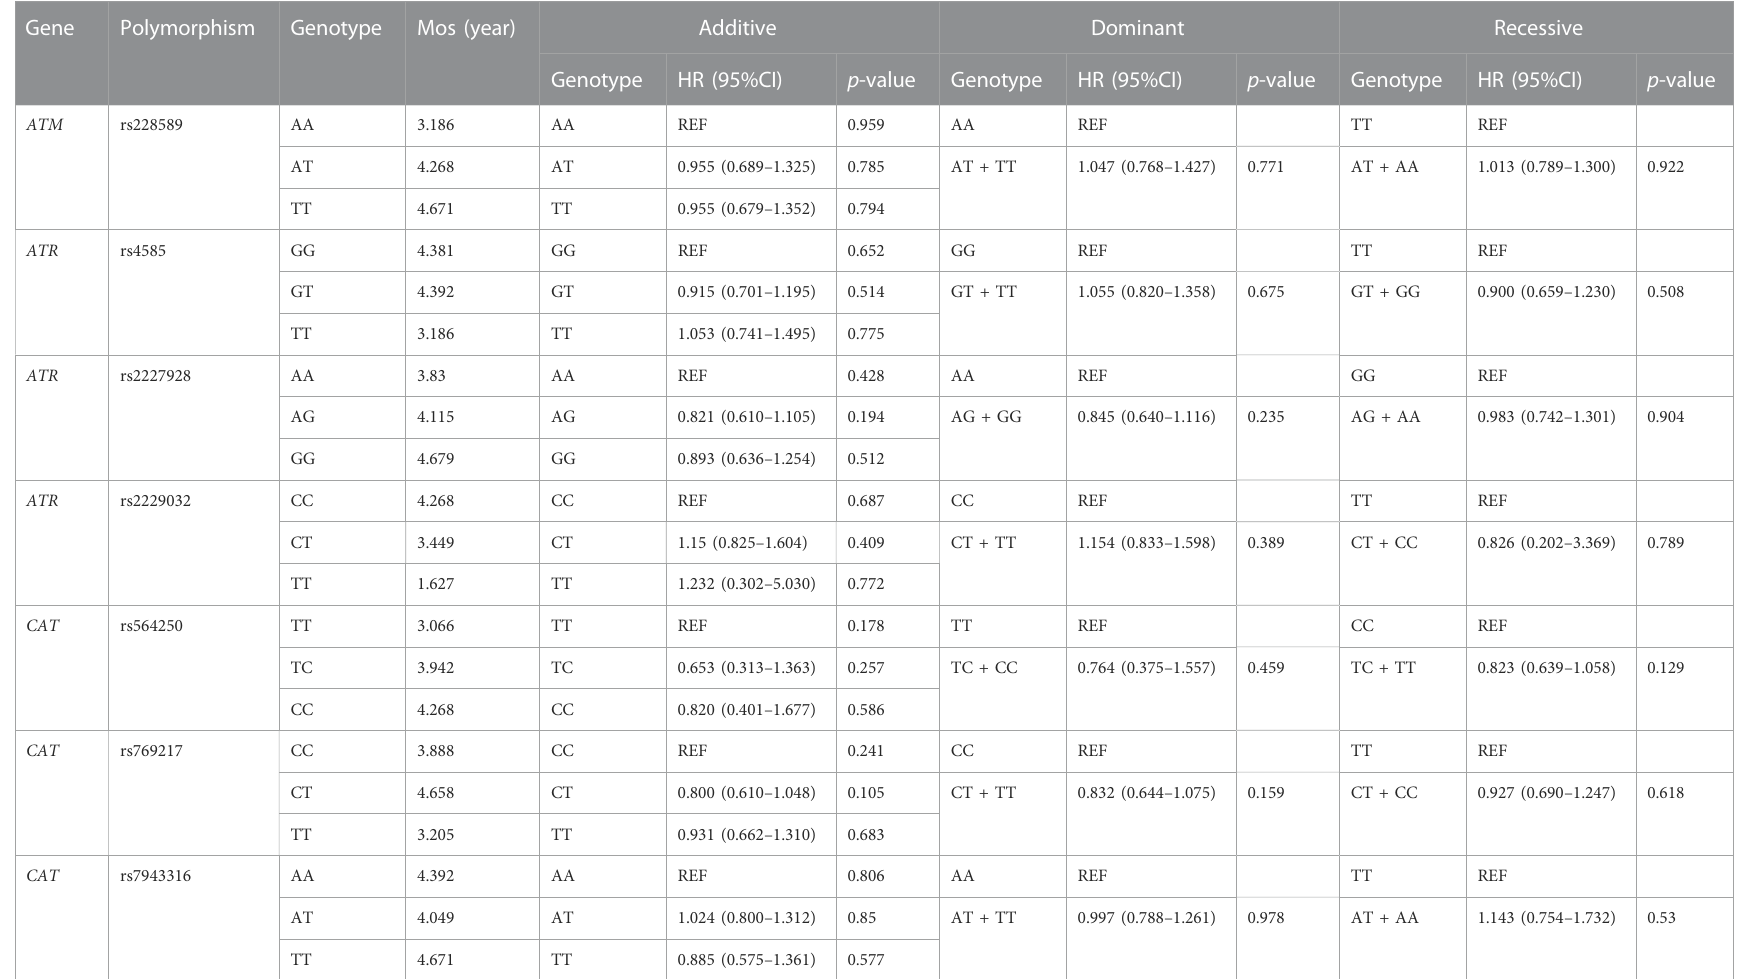
TABLE 3 Association of 7 SNPs polymorphisms and